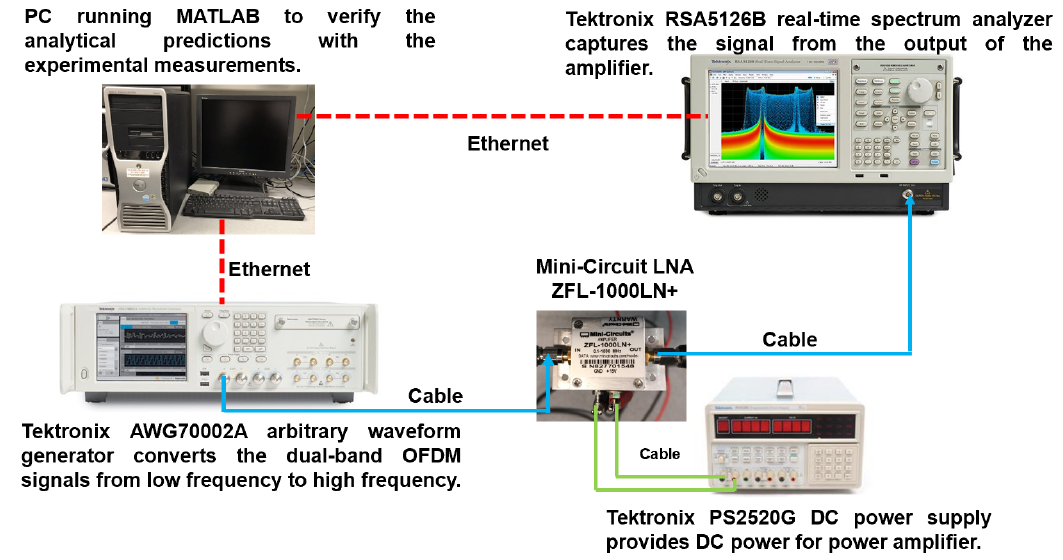
Figure 3. Experiment